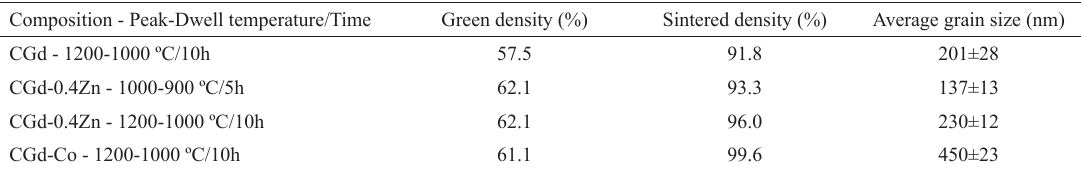
Table 1: Green, final relative density and average grain size of samples sintered by a two-step method. Composition - Peak-Dwell temperature/Time Green density